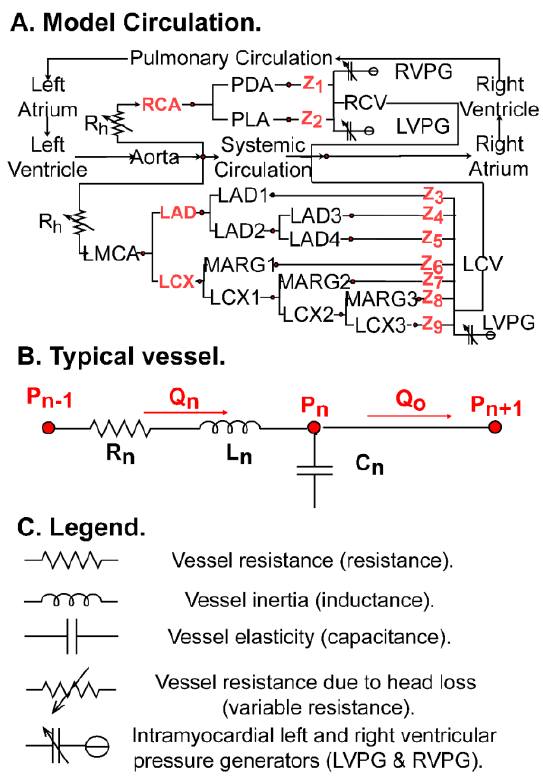
Figure 1. The modelled lumped parameter coronary vasculature tree network. ( A ). Closed loop vascular structure including tree network and functional components. See Table 1 for vessel names. Z i ( i = 1 to 9) represent terminal vessel impedances. Vessels as well as impedances shown in red were used in the simulation experiments. ( B ). Typical blood vessel represented by a resistance (R n ), inductance (L n ), and a capacitance (C n ). P n−1 : vessel inlet pressure; Q n : flow through vessel; P n : pressure in vessel; Q o : outlet flow; P n+1 : outlet pressure, or pressure in distal vessel. ( C ). Symbols used in panels A, B, and elsewhere in this work.